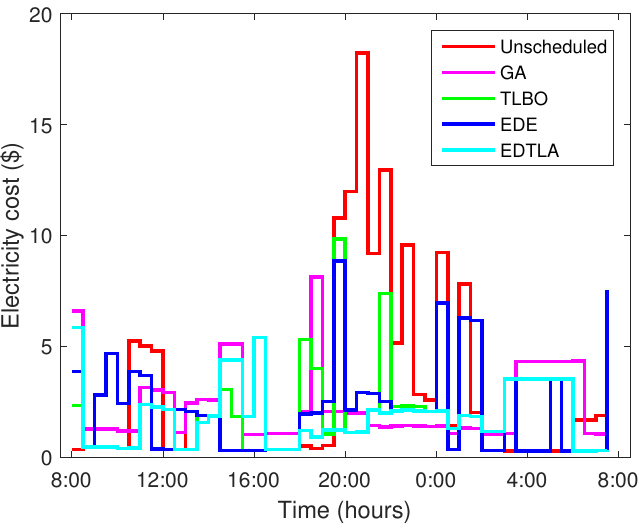
Figure 14. Hourly electricity cost.